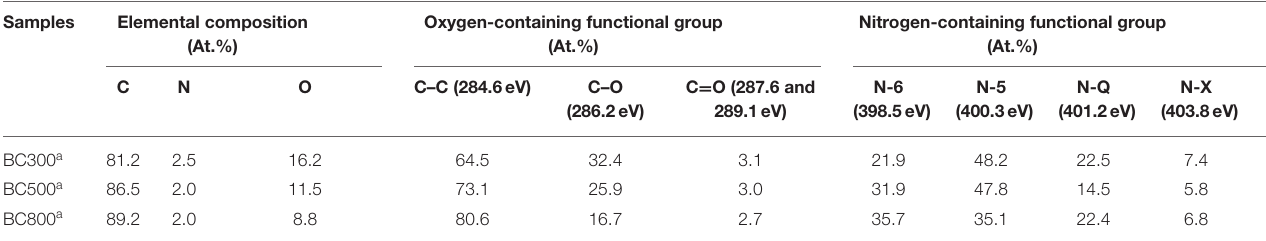
TABLE 2 | Elemental composition, oxygen-containing functional groups, and nitrogen-containing functional groups of biochar surface from XPS analysis. Samples Elemental composition